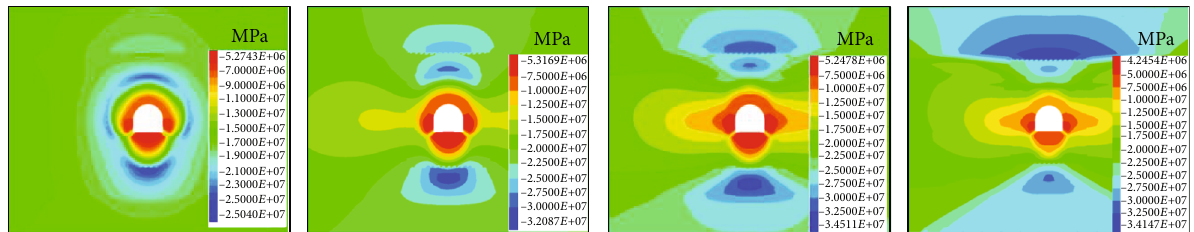
Figure 3: The principal stress di ff erence under di ff erent deviatoric stresses.